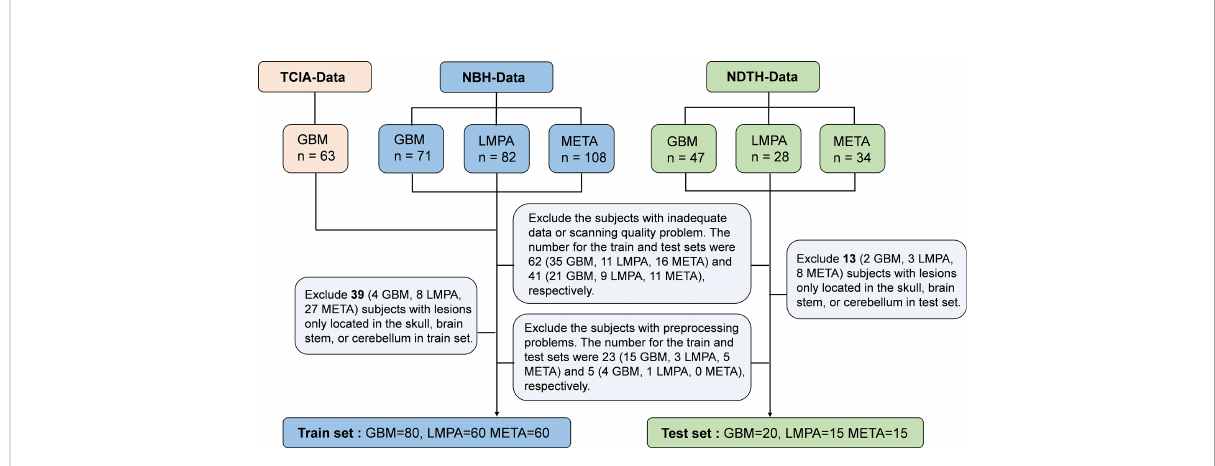
FIGURE 1 Data organization of the patients from three data